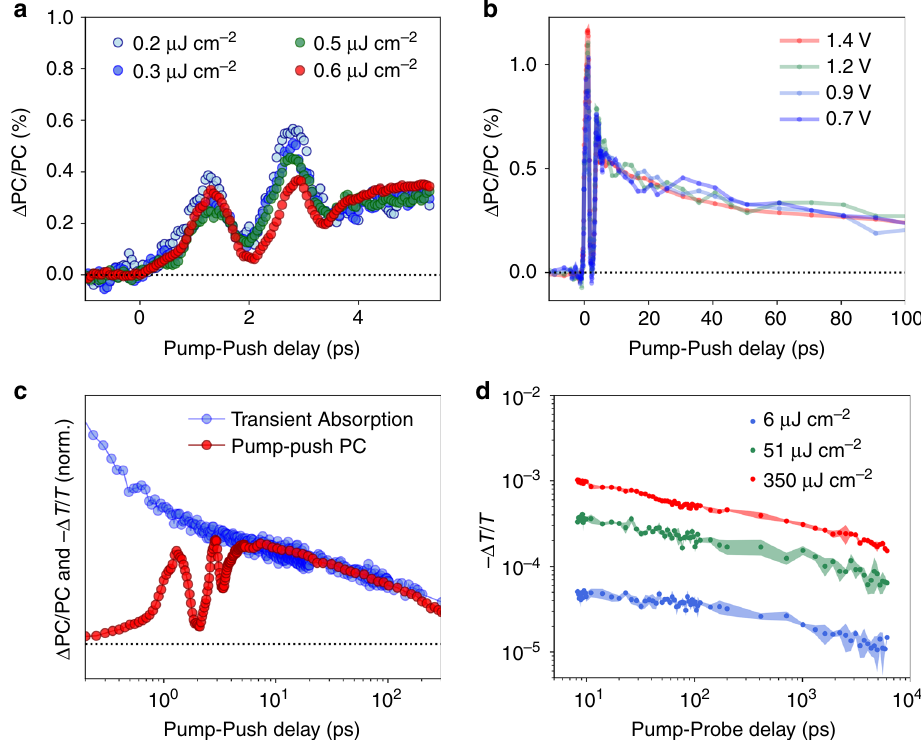
Fig. 3 Charge carrier density and fi eld dependence. a Pump – push-photocurrent (PPPC) response at early times of the α -Fe 2 O 3 PEC at different pump powers and a fi xed push power per pulse (1.7 µ J pulse − 1 ). b PPPC response at a wider time range at different applied potentials vs a Pt counter electrode (see the Methods section for details). c Comparison of the TA and PPPC signals across a broad time range. While TA is primarily sensitive to all states in the system (localised and delocalised), the PPPC is only sensitive to bound (localised) states; at early times, when polaron formation occurs, the two signals have different pro fi les. At longer times, when the polaronic state dominates, both assays show the same response. d TA decay at different pump powers (coloured dots and standard deviation) showing a power-law decay kinetics characteristic of recombination via trap/defect states as previously reported for α -Fe 2 O 3 and other metal